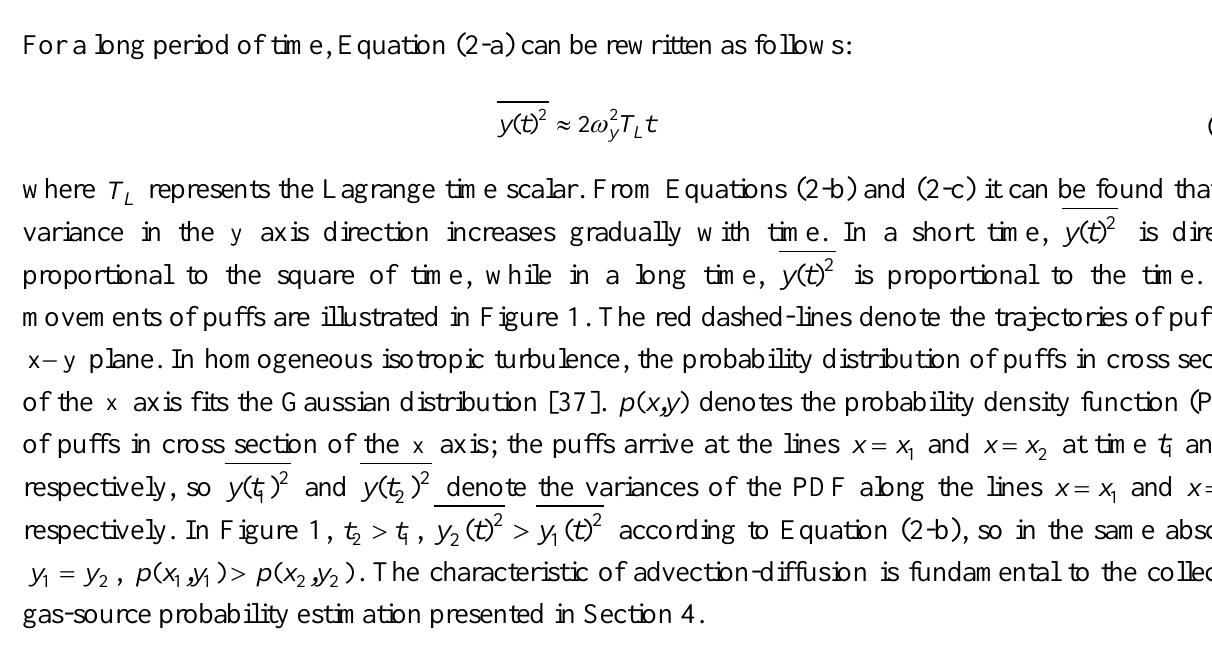
Figure 1. The schematic diagram of probability density distribution of